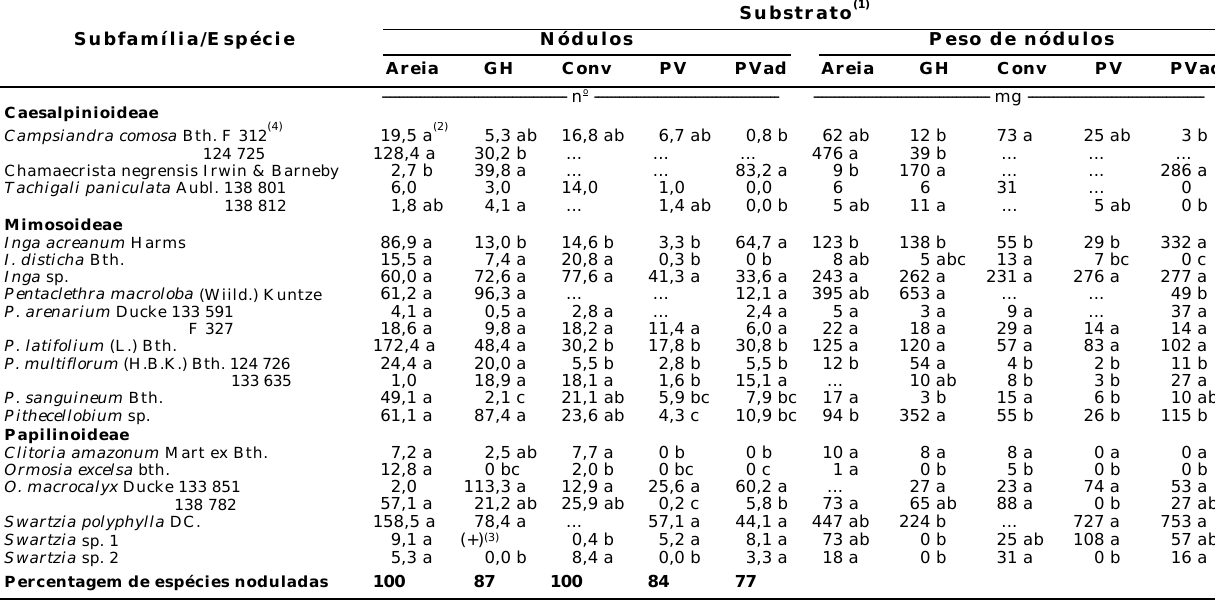
de podzólico vermelho-amarelo coletado na Reserva Floresta Ducke (Manaus) e PVad - substrato PV adubado (por saco) com: 3 g de calcário dolomítico, 0,2 g de superfosfato simples, 0,2 g de fosfato de rocha (Bauxita do Maranhão), 4 ml de K solução de micronutrientes. (2) Médias (de 5 plantas) seguidas por letras distintas na mesma linha diferem entre si ao nível de 5% pelo teste de Duncan. (3) Nódulos presentes mas não avaliados. (4) N o registro no herbário das diferentes procedências da espécie. Obs.: A procedência 124726 de Pithecellobium multiflorum nodulou no substrato AREIA e Pithecellobium adiatifolium nodulou nos substratos AREIA e CONV e não nodulou em PVad. As espécies dos gêneros nodulíferos Sclerolobium e Swartzia ( S . sp 3) não nodularam no